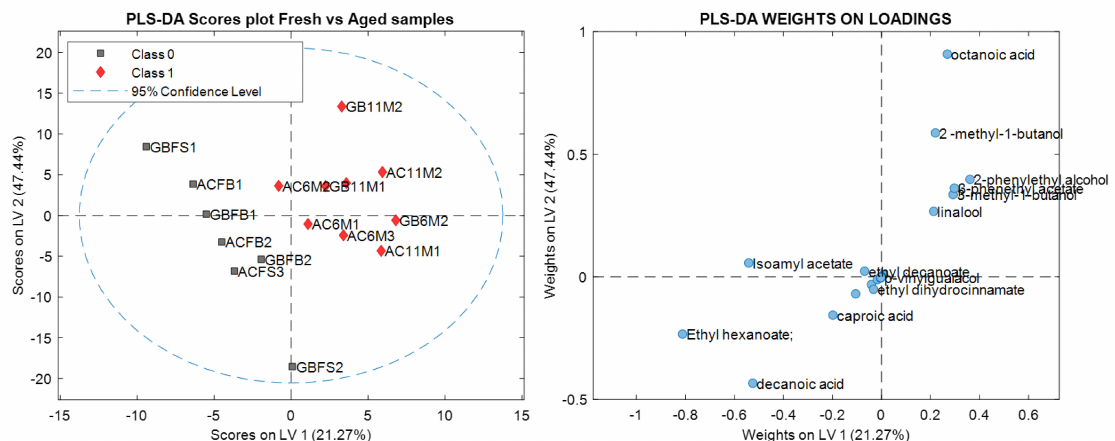
Figure 2. Score and loading plots for the first two factors of the PLS-DA model fresh vs. aged. Grey circles indicate fresh beers, red triangles aged beers and blue circles names of volatile compounds